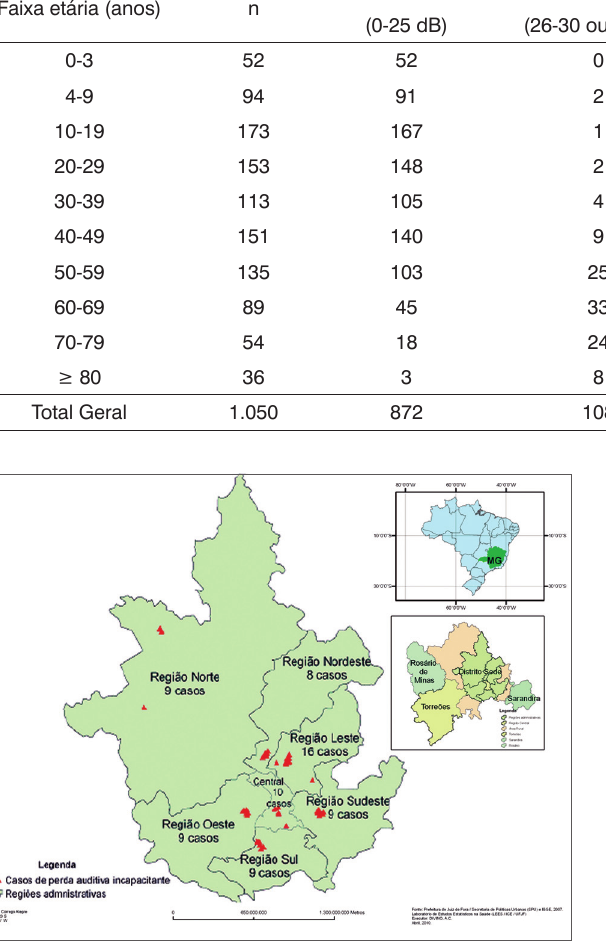
como Serra Leoa, com muito baixo IDH (0,317) apresenta